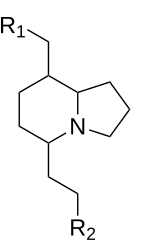
Figure 2. Parent structure of Indolizidine